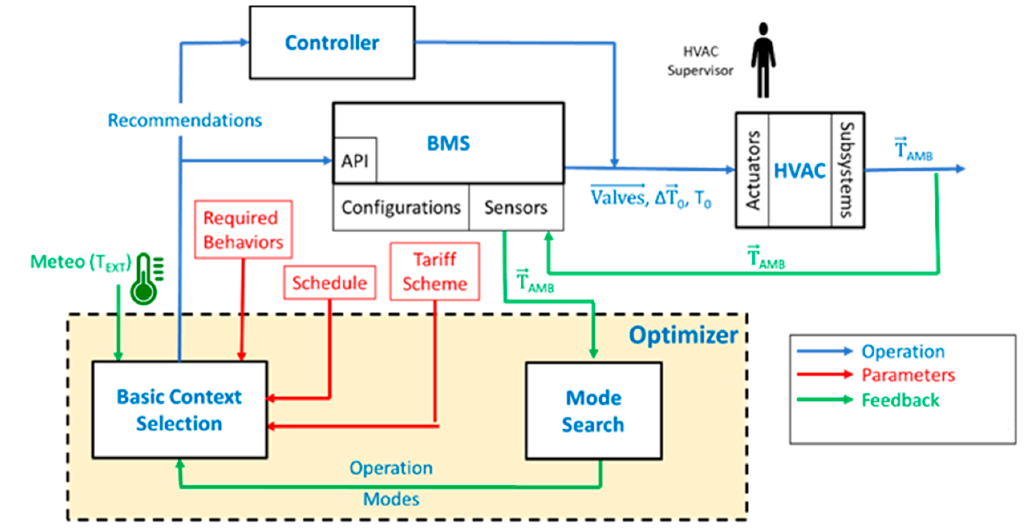
Figure 4. ACODAT-based first integration.